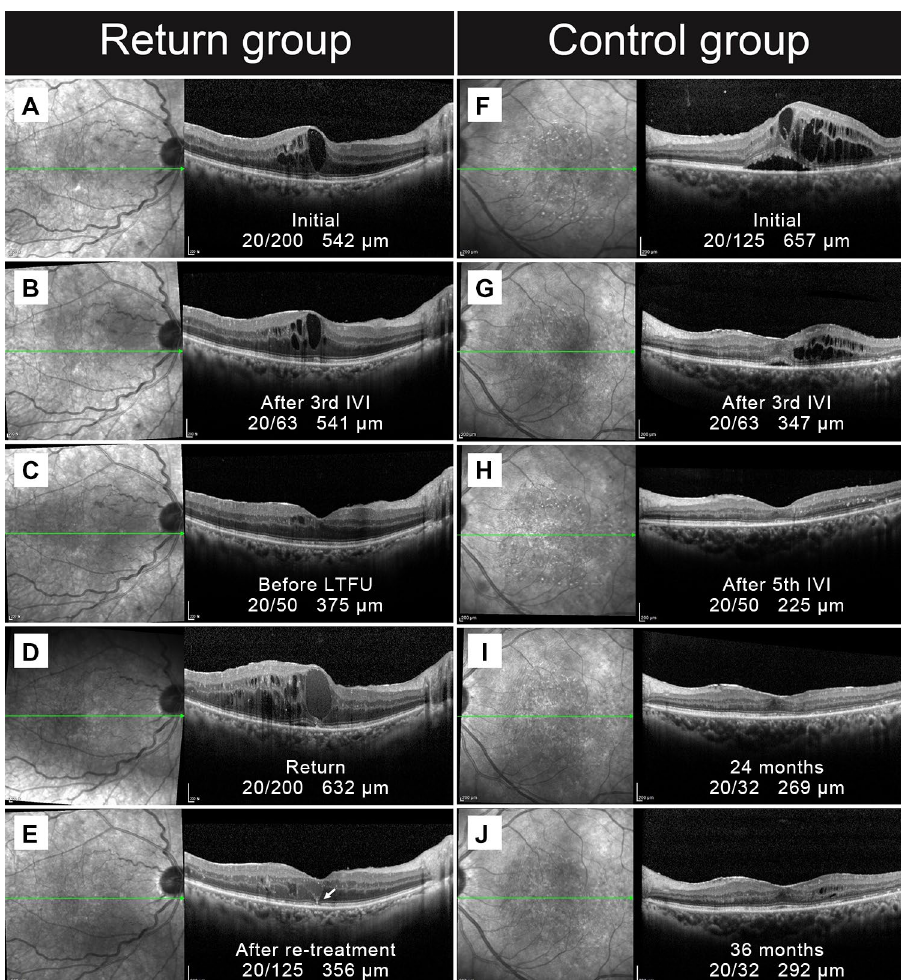
Figure 3. Representative cases of DME patients lost to follow-up. ( A – E ) A representative case of the return group. A 61-year-old man with the pseudophakic eye was lost to follow up after initial treatment with bevacizumab injection ( A – C ). When the patient revisited after 18 months, the BCVA and CST were worsened ( D ). After re-treatment, though the CST improved, BCVA did not recover to the previous level before LTFU. An ellipsoid zone defect (white arrow) appeared. ( F – J ) A representative case of the control group. A 66-year- women with pseudophakic eye regularly visited our clinic for three years. And a total of eighteen injections were administered in that period. The BCVA and CST were improved after initial treatment.